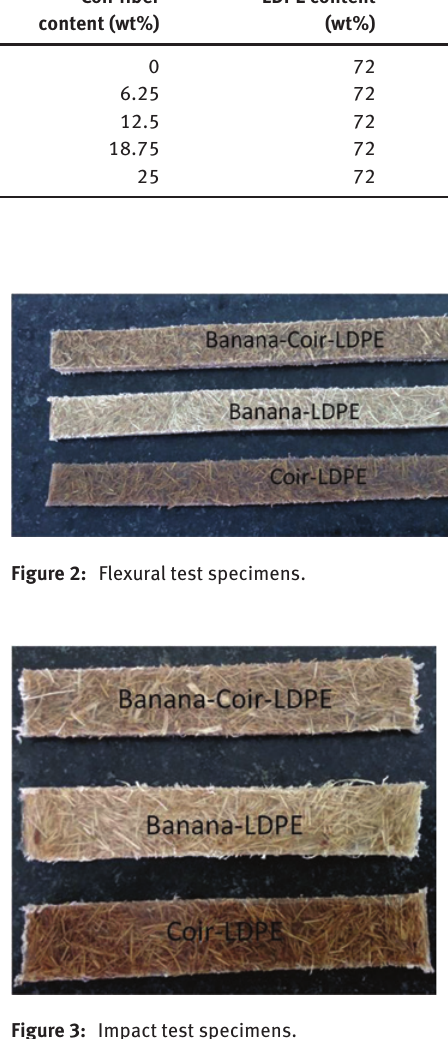
Figure 3: Impact test